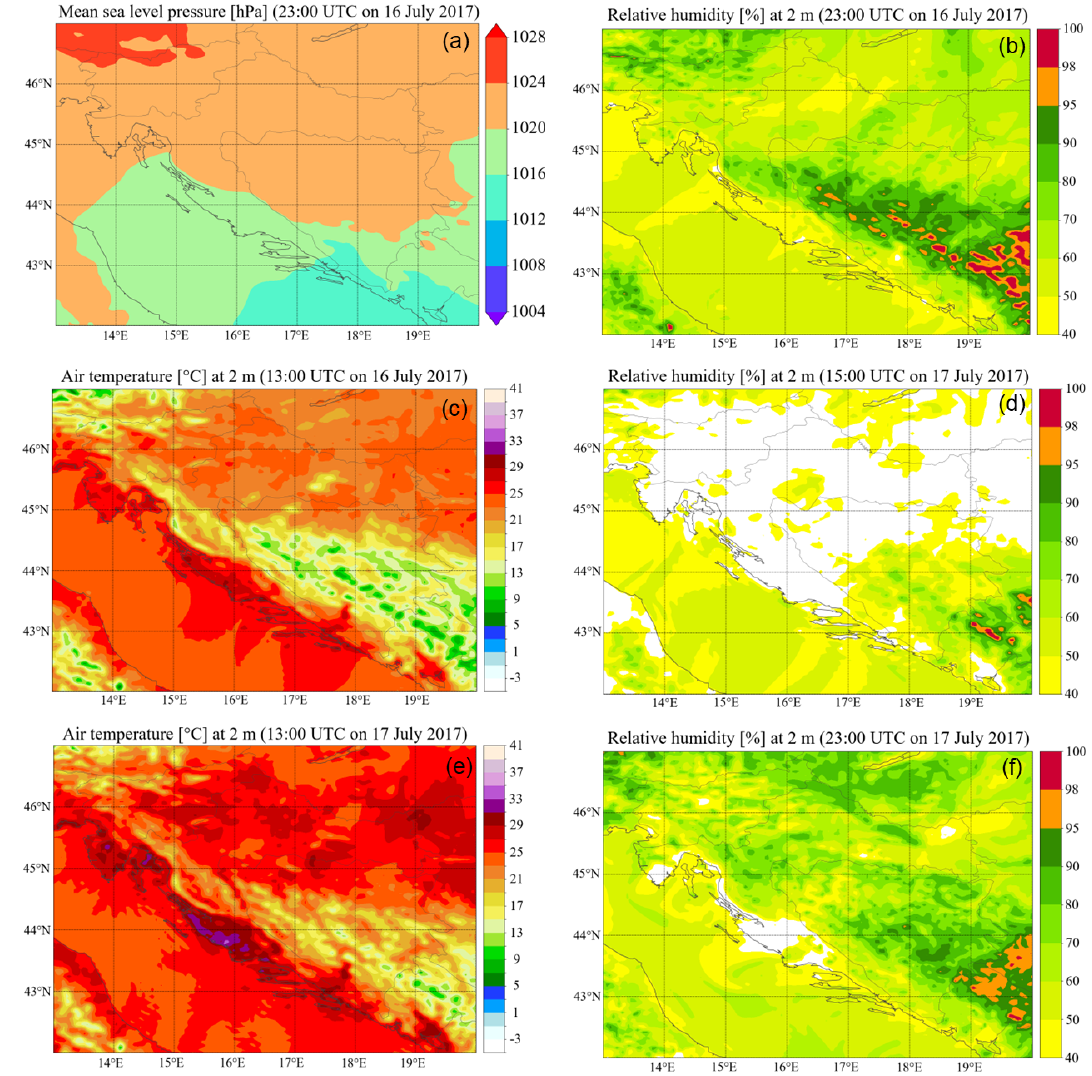
Figure 9. (a) Mean sea level pressure (hPa; colored) and (b) relative humidity (%; colored) at 2m, both valid for 23:00UTC on 16 July; (c) air temperature ( ◦ C; colored) at 2m valid for 13:00UTC on 16 July; (d) relative humidity (%; colored) at 2m valid for 15:00UTC, (e) air temperature ( ◦ C; colored) at 2m valid for 13:00UTC, and (f) relative humidity (%; colored) at 2m valid for 23:00UTC, all valid for 17 July 2017 from the ALADIN-HR44